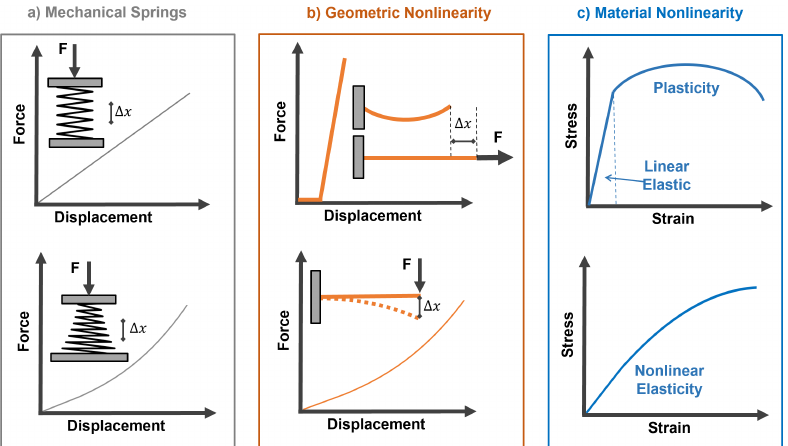
Figure 3. ( a ) Force–displacement response for linear (top) and nonlinear (bottom) conical springs, where F is the applied force, and ∆ x is the displacement; ( b ) examples of geometric nonlinearity in slack–tension (top) and bending (bottom) structural members; and ( c ) stress–strain in materials exhibiting elastoplasticity (top) and nonlinear elasticity